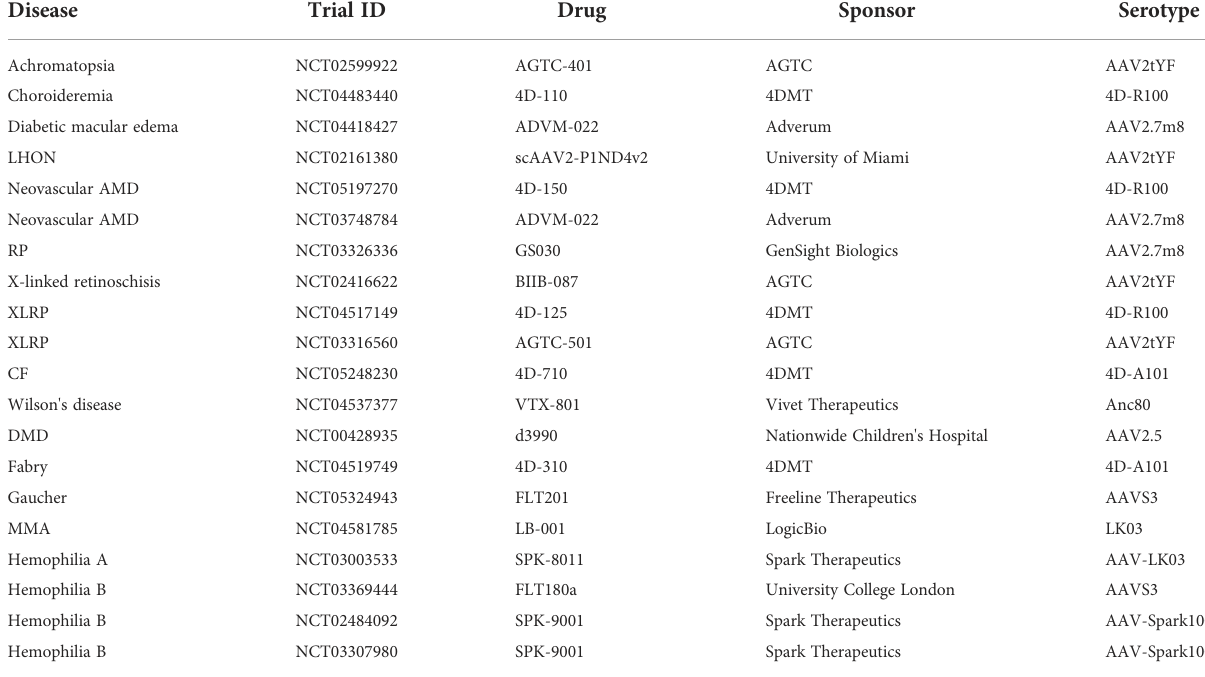
TABLE 1 Clinical trials using engineered AAV